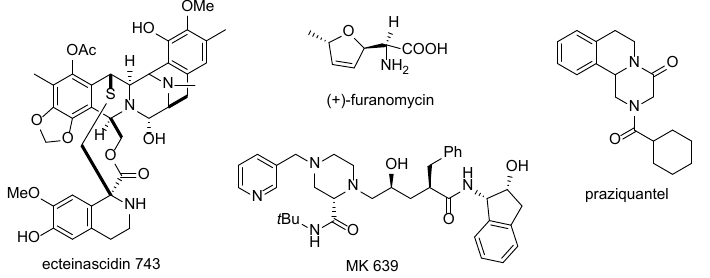
Figure 1. Important compounds from post-Ugi reactions.